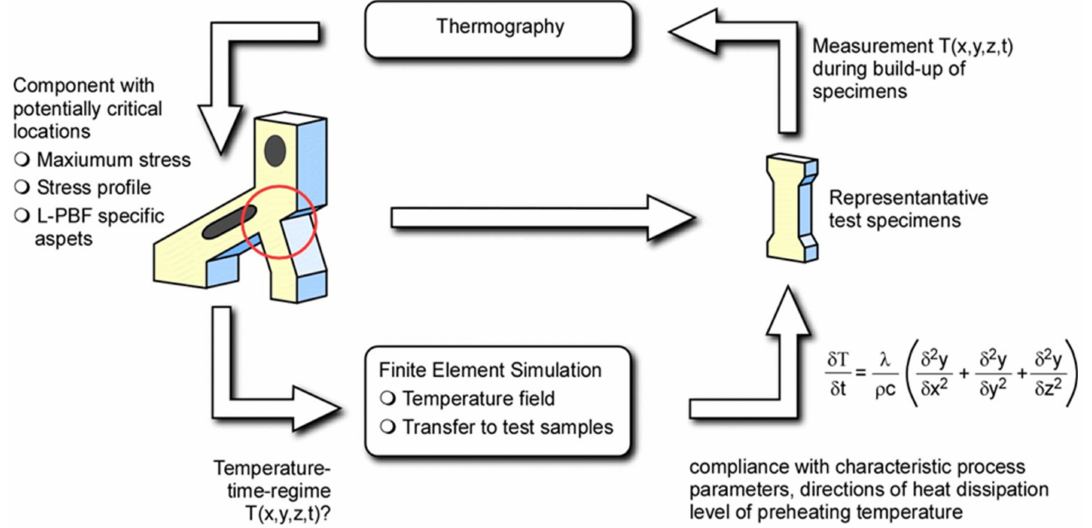
Figure 13. Principle of the fabrication of representative test specimens for the damage critical locations in an L-PBF